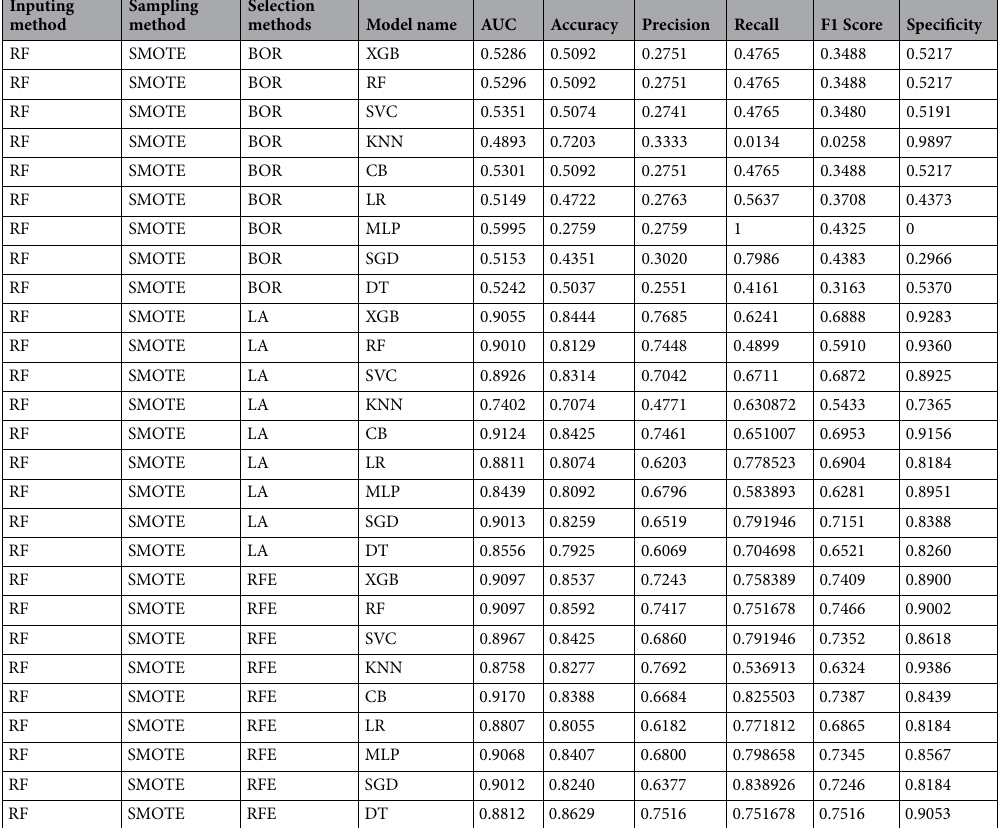
Table 2. The effect of different machine learning algorithms on model prediction performance using SMOTE sampling method. SMOTE synthetic minority oversampling technique, BOR boruta screening, RFE recursive feature elimination, LA lasso screening, XGB extreme gradient boosting, SVC support vector classify, KNN K-nearest neighbor, CB category boosting, LR logistic regression, MLP multilayer perceptron, SGD stochastic gradient descent, DT decision tree, AUC area under the curve.